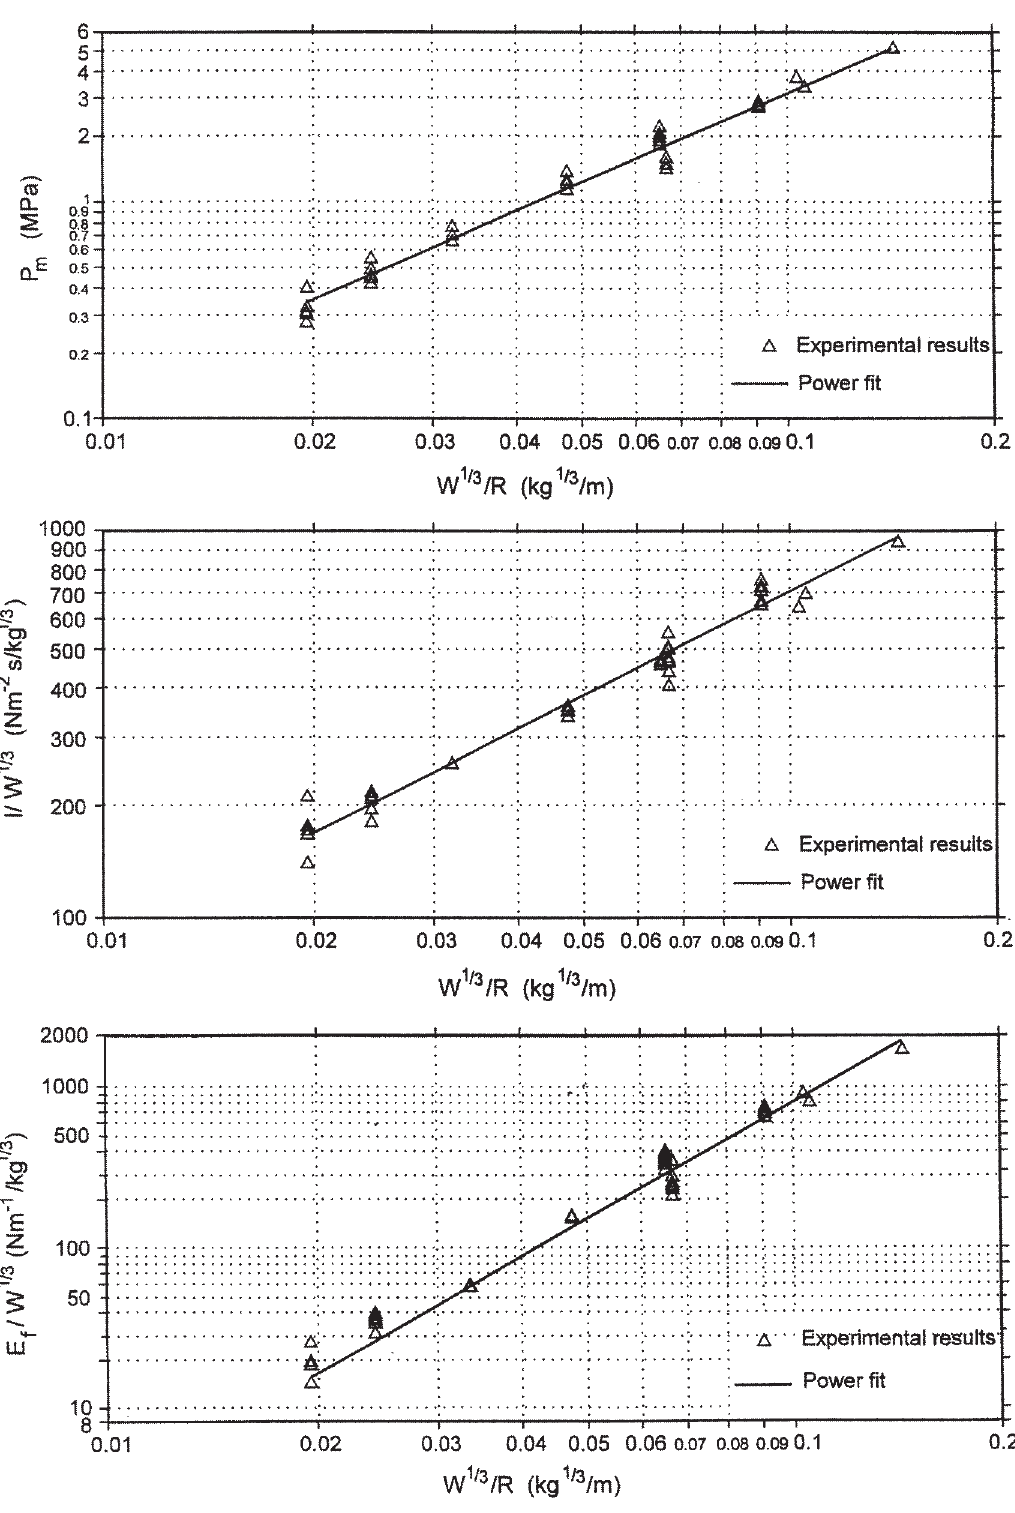
Fig. 11. Fitted models of shock wave pressure pulse characteristics for detonator type